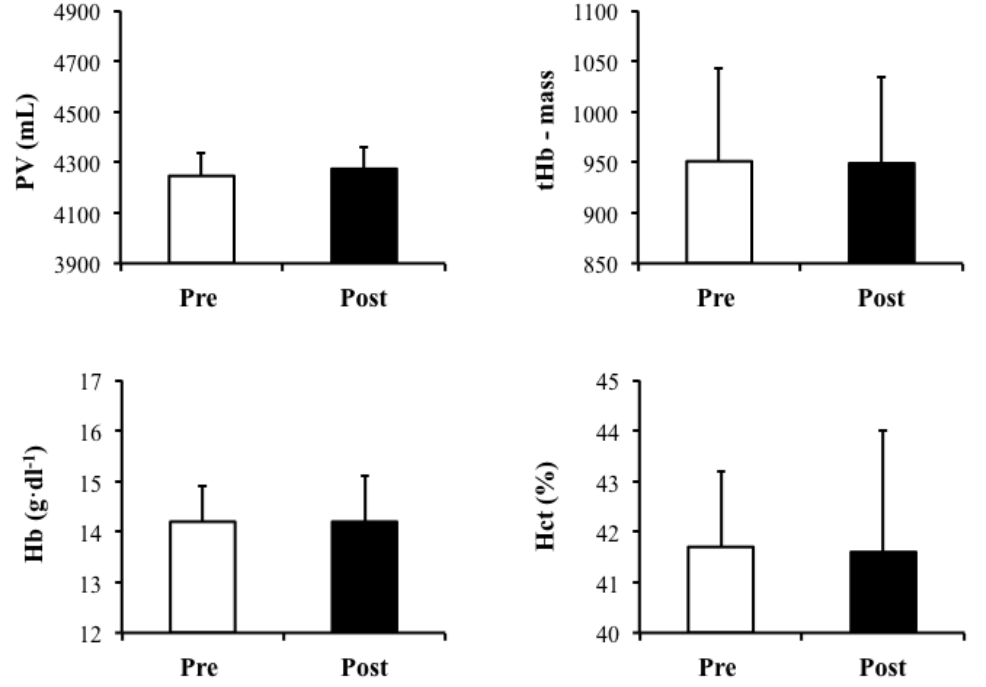
Figure 4. Plasma volume (PV) (mL), total Hb mass (tHb-mass), total hemoglobin (Hb) (g·dL − 1 ) and hematocrit (Hct) (%) pre- and post-supplementation with the hyperhydrating solution containing Gly, Cr and Glu. Data presented as Mean ± S.D., N =